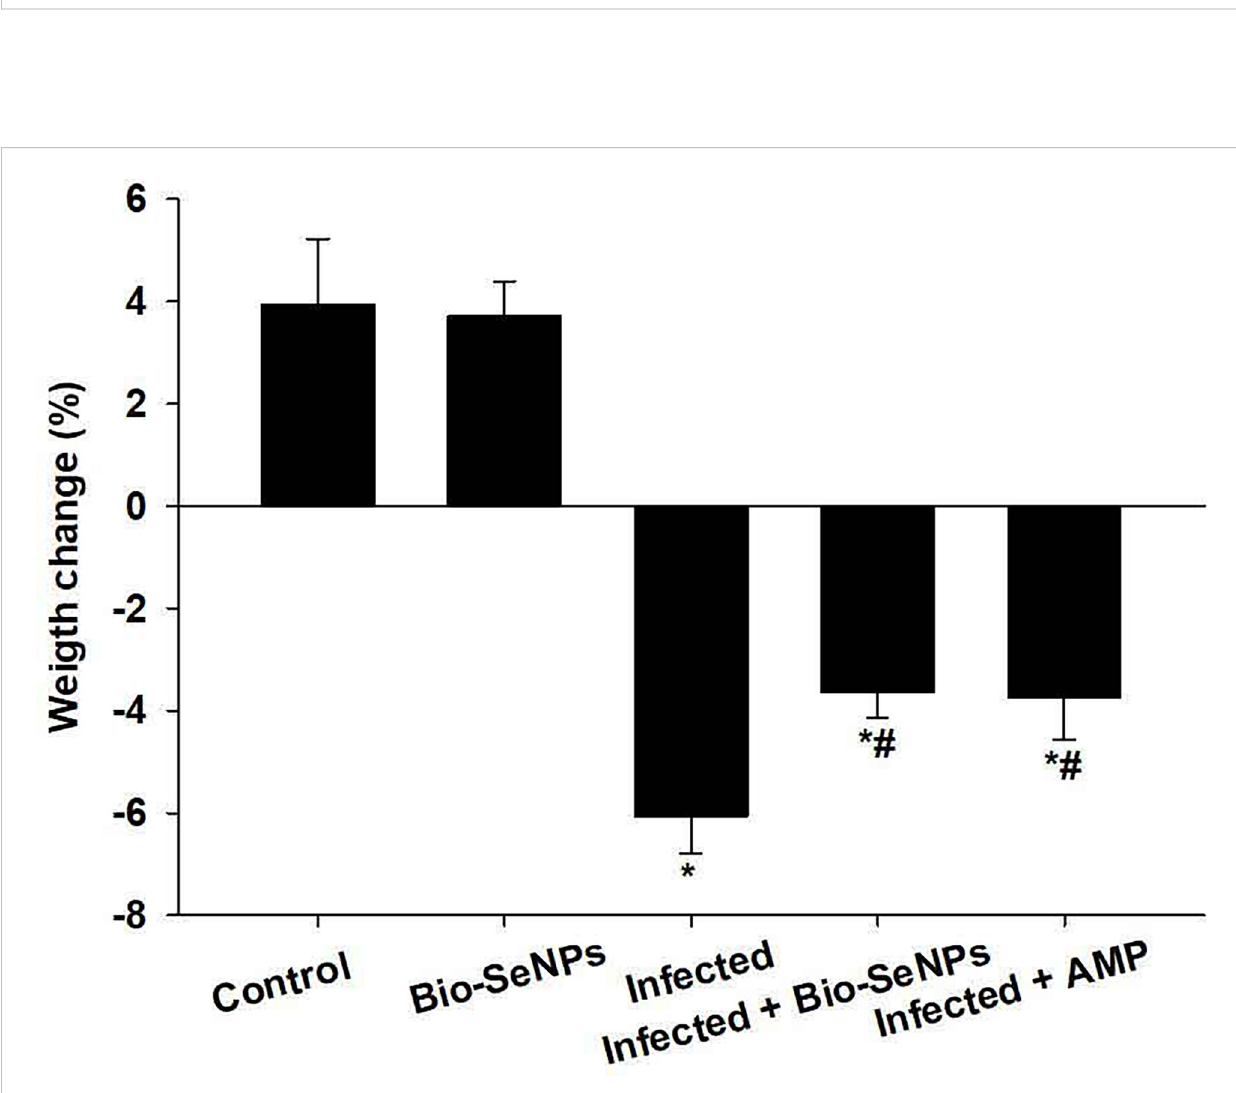
FIGURE 3 Bio-SeNPs improved weight loss due to infection with Eimeria papillata in mice. Values are means ± SEM. * signi fi cance (P ≤ 0.05) against non- infected control group, # signi fi cance (P ≤ 0.05) against infected